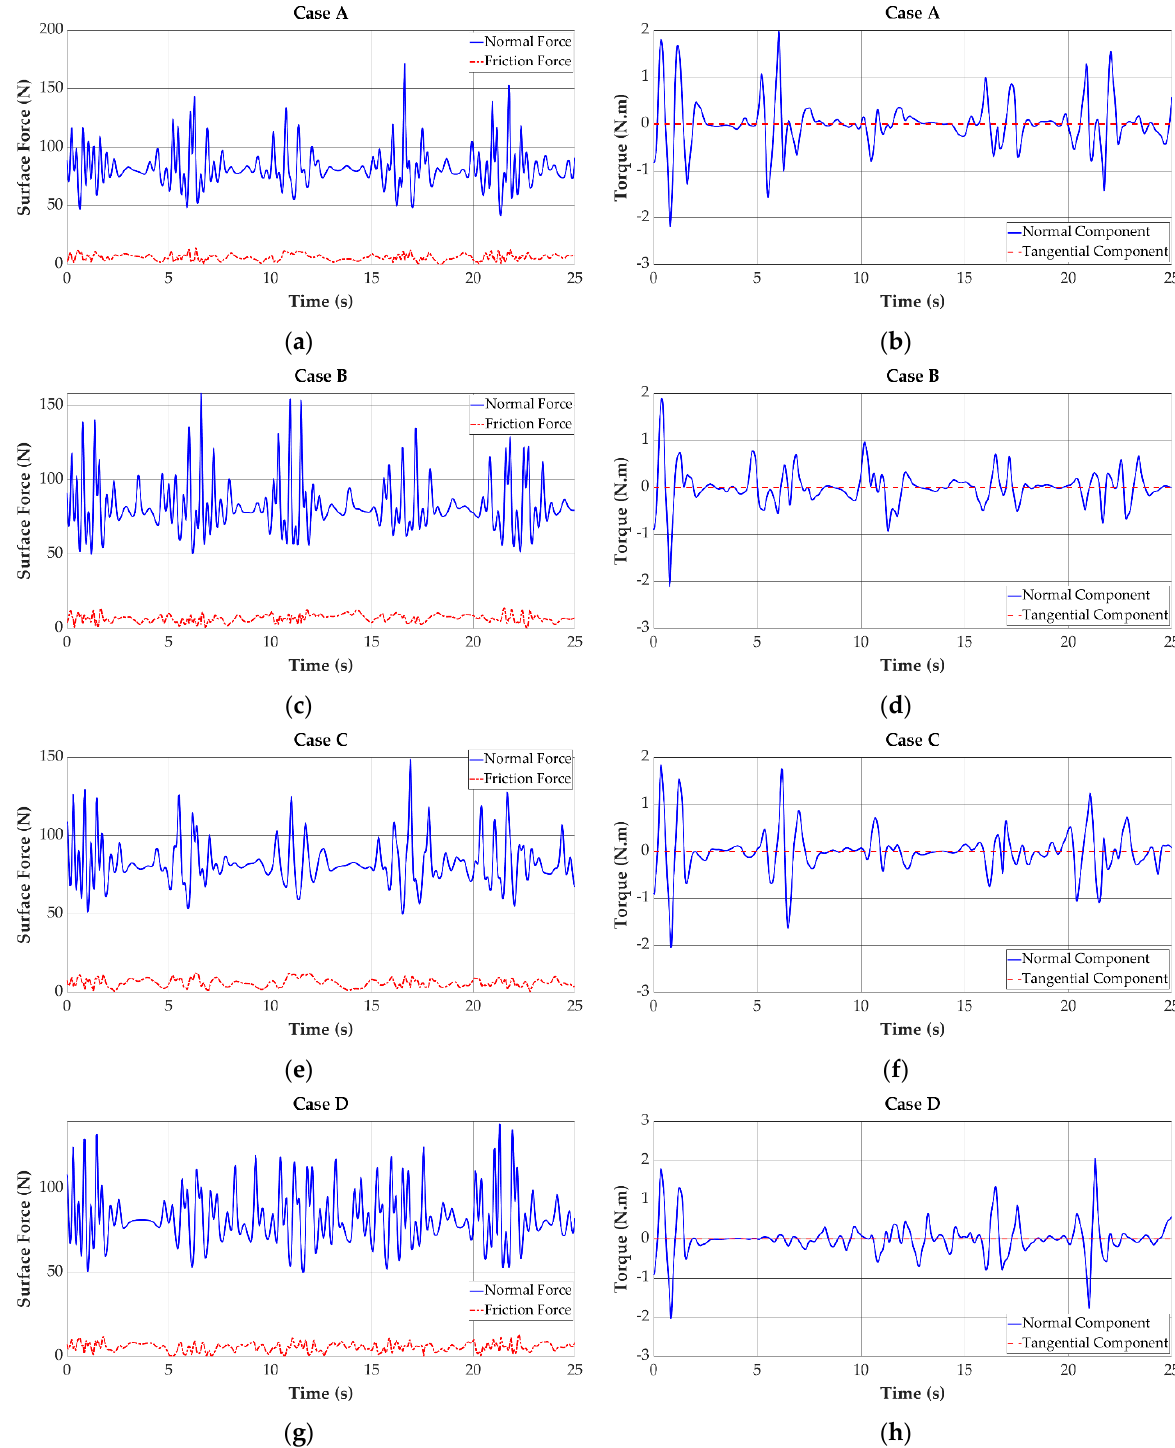
Figure 12. Example 3. Magnitude of normal and frictional forces provided by the surface to the shell at P on the left and the torque T P that is required to be externally applied to satisfy the No-Spin XYZ constraint on the right. ( a , b ) Case A, ( c , d ) Case B, ( e , f ) Case C, ( g , h ) Case D. The minimum values of the coefficient of friction required for the shell Σ not to slip over the surface Γ during its computed motion for Cases A to D are: µ A = 0.21, µ B = 0.19, µ C = 0.16 and µ D = .